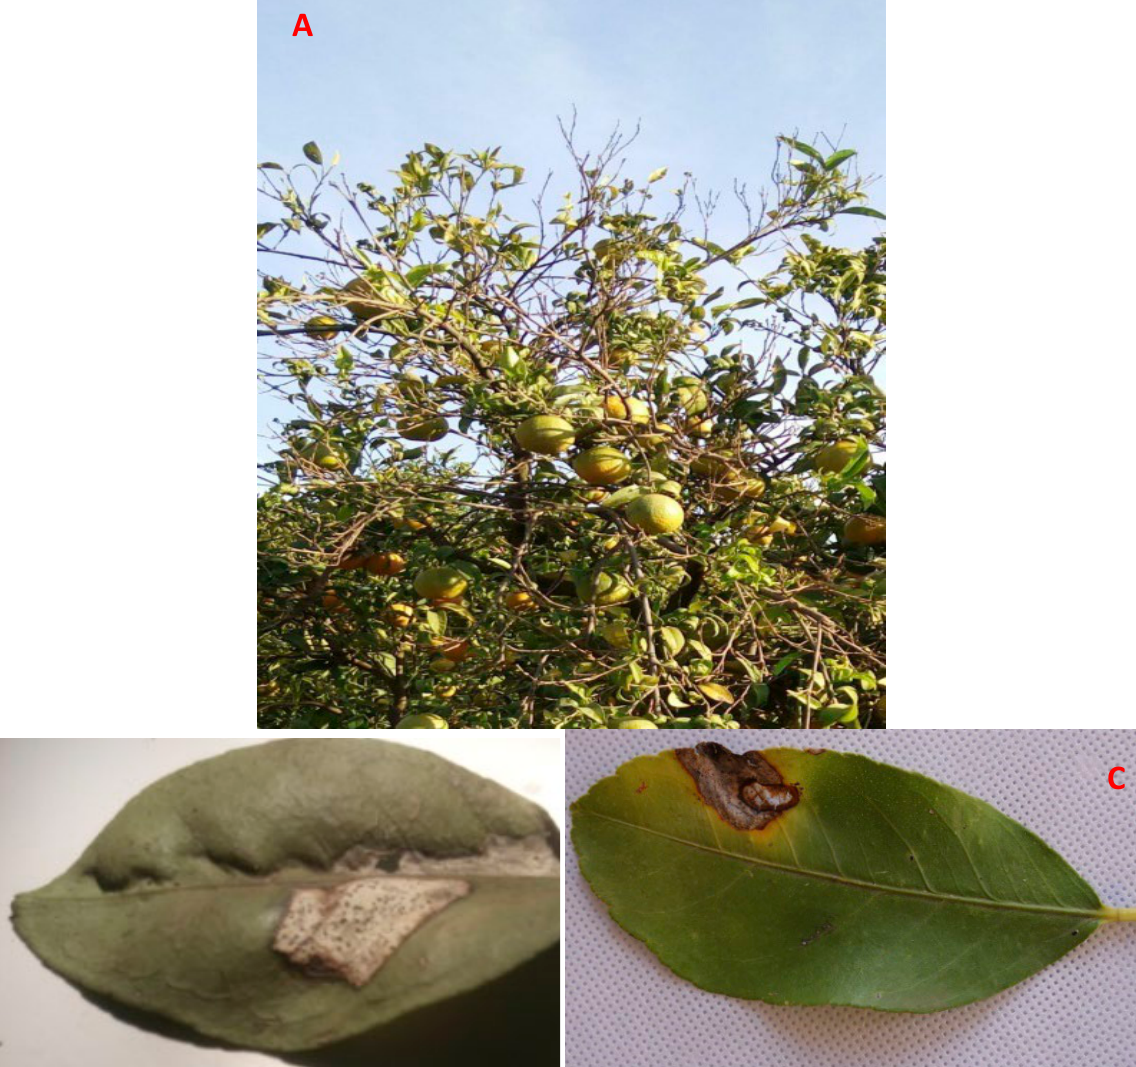
Figure 1. Anthracnose symptoms observed on sweet orange cv. Thomson Navel (A); leaf lesions associated with black fructifications (acervuli) on orange leaf (B) and on lemon leaf